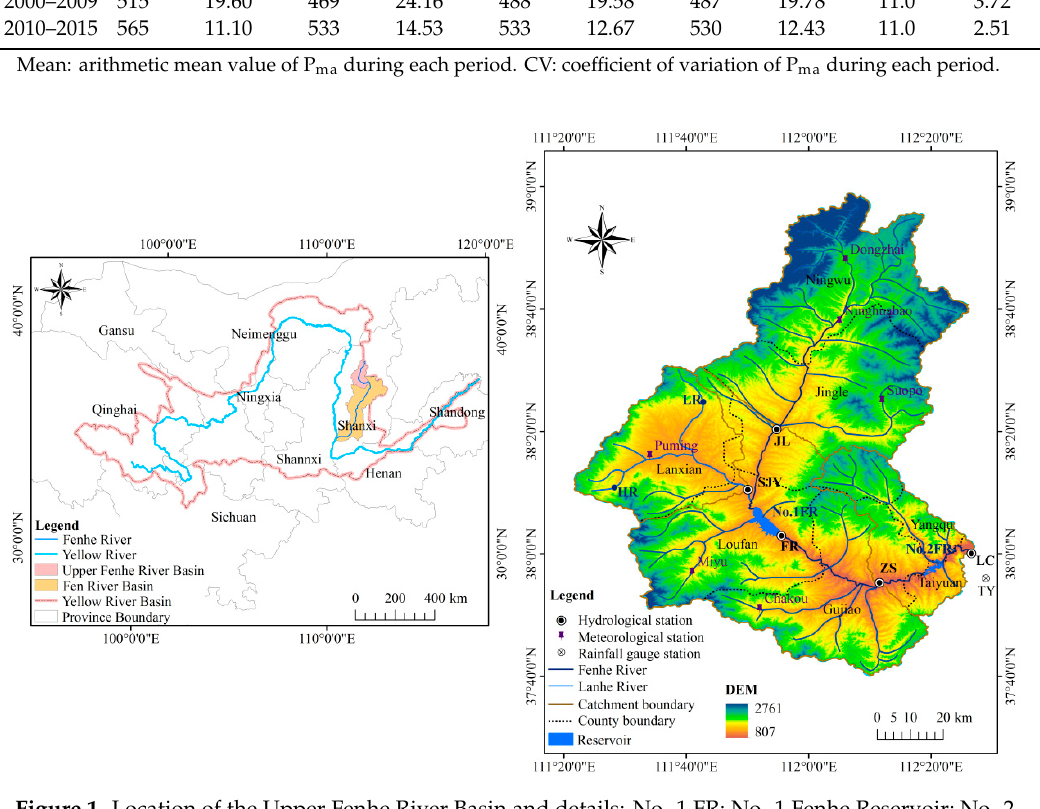
Figure 1. Location of the Upper Fenhe River Basin and details: No. 1 FR: No. 1 Fenhe Reservoir; No. 2 FR: No. 2 Fenhe Reservoir; LR: Lancheng Reservoir; HR: Hamashen Reservoir.